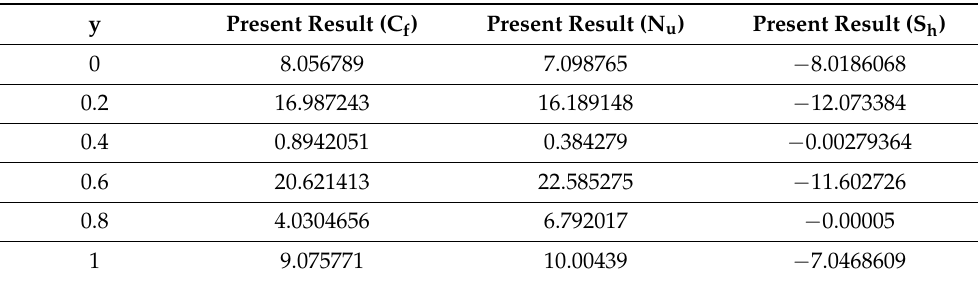
Table 2. Results of the skin friction coefficient C f , Nusselt number N u , and Sherwood number S h obtained by MS-DTM. G rT = 0.5, G rC = 0.5, G rF = 0.5, N CT = 0.7, N TC = 0.7, N b =